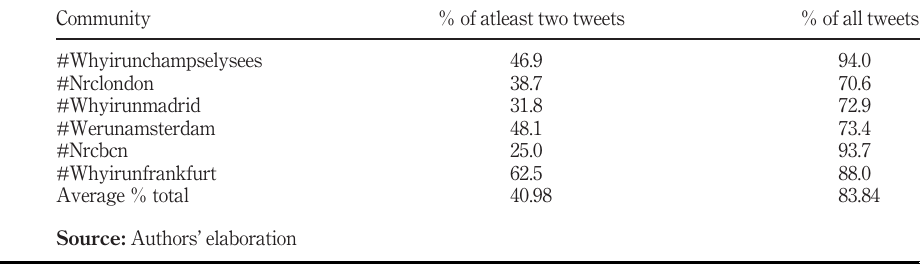
Table III. Users ’ level of